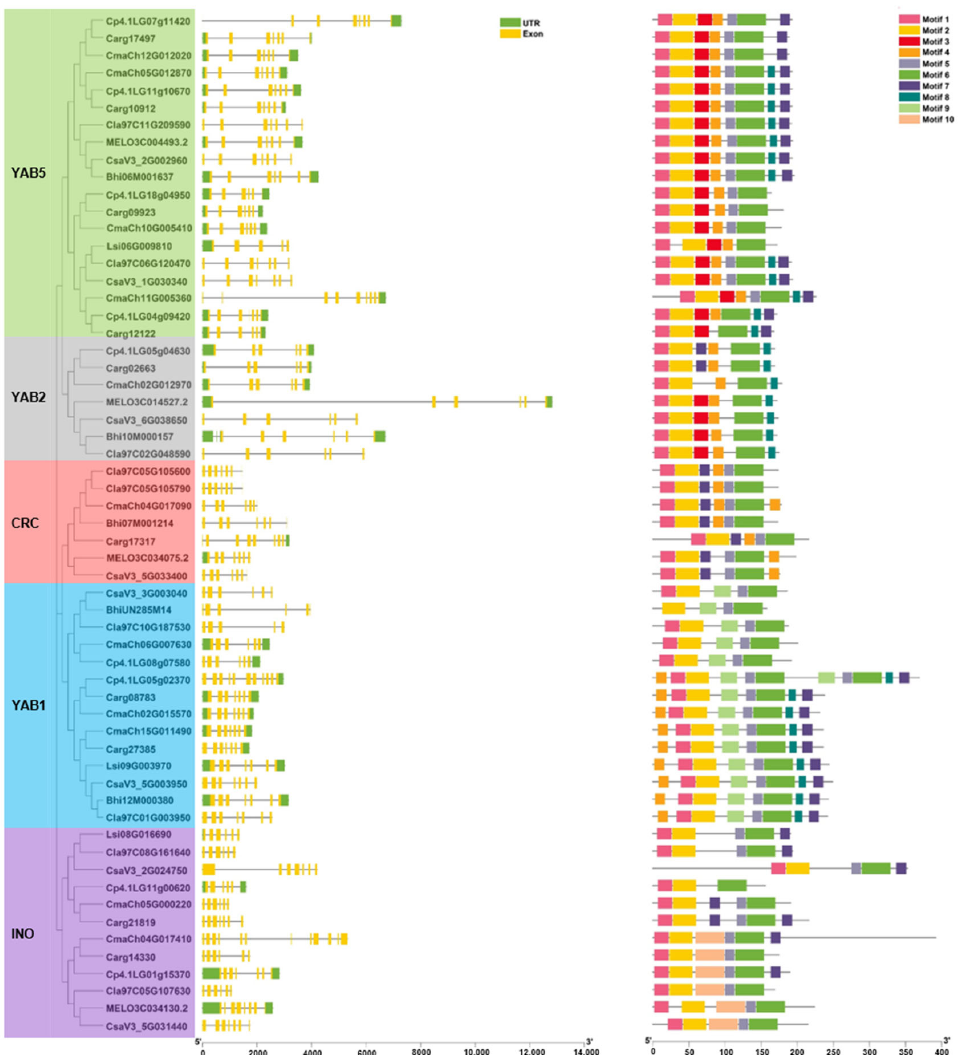
Figure 3. Phylogenetic clustering, conserved motifs, and gene structure of YABBY genes from eight cucurbit species. Left panel: unrooted phylogenetic tree of YABBY proteins. Light green, gray, light red, blue and purple part represent YAB5, YAB2, CRC, YAB1, and INO subfamilies, respectively. Middle panel: gene structure of YABBY genes. Untranslated regions and exons are indicated by green boxes and yellow boxes, respectively. Right panel: the conserved motifs of YABBYs are represented by different colored boxes.